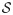
Stochastic switching trajectories concentrate along the MAP with rates that change along the bistable zone.(a) Stochastic switching trajectories are compared for CLE (red) and exact realisations of the kinetic reactions through the Gillespie algorithm (green) for two different values of Ω for the stochastic transition A → B. The trajectories concentrate along the MAP (solid blue line), which passes through the saddle point (black circle). This indicates that the MAP is consistent with the stochastic simulations. (b) The action S and the prefactor C depend on the level of the signal. Top) The value obtained for S by the minimisation of the action functional (solid lines) compared with the patterning times obtained for 10000 averaged switching CLE trajectories for each signal value (circles). Error bars indicate standard error from the fitting (see S1 Text). The logarithm of the switching times are lnC+ΩS, which predicts that switching rates from B to A increase dramatically with M, whilst the switching rate from A to B decrease, provided Ω is reasonably large. Parameters are those of Fig 4.